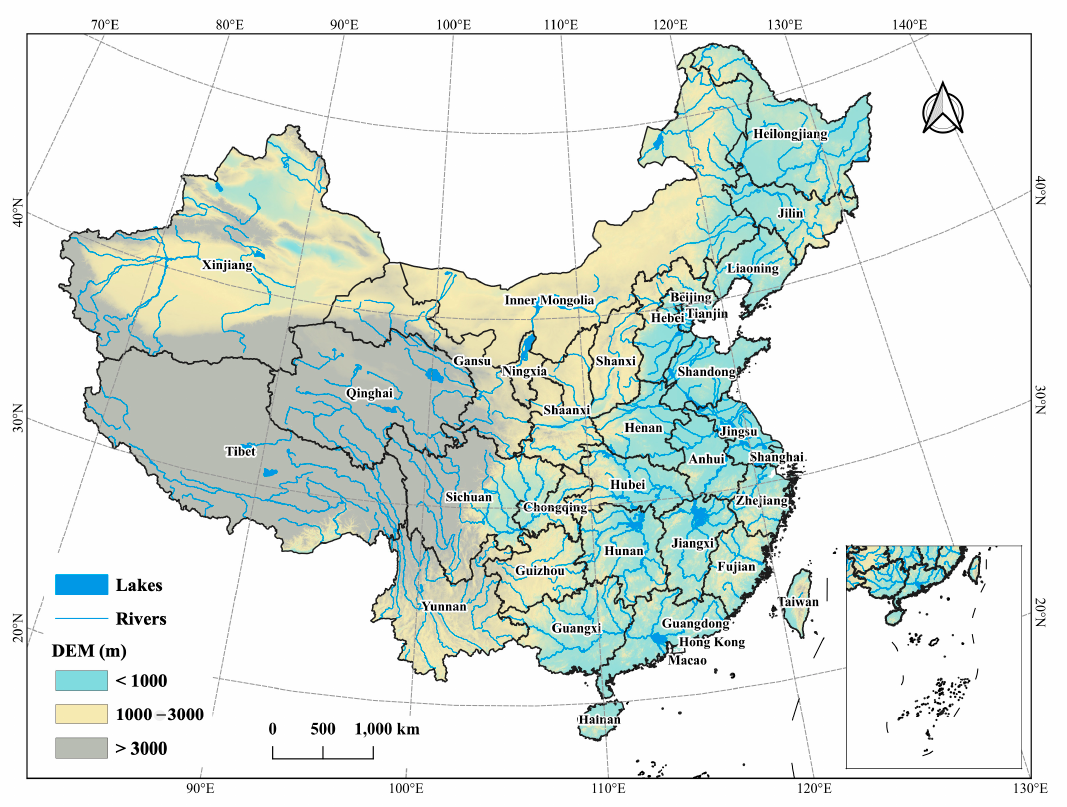
Figure 1. Geographic map of